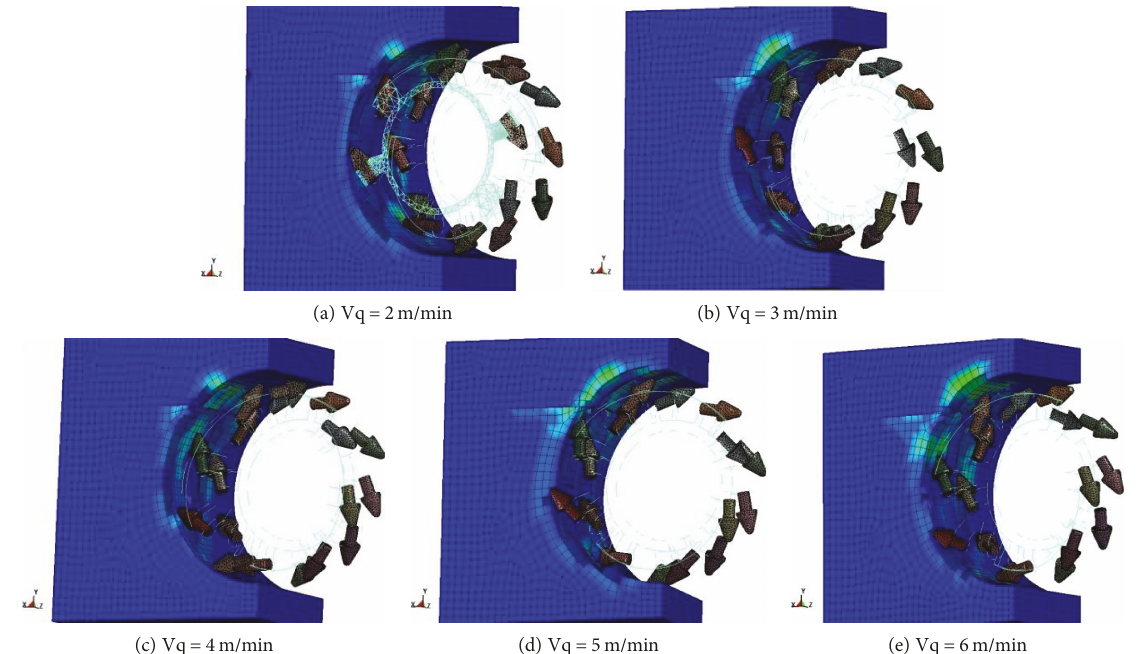
Figure 5: Di ff erent traction speeds and coal rock